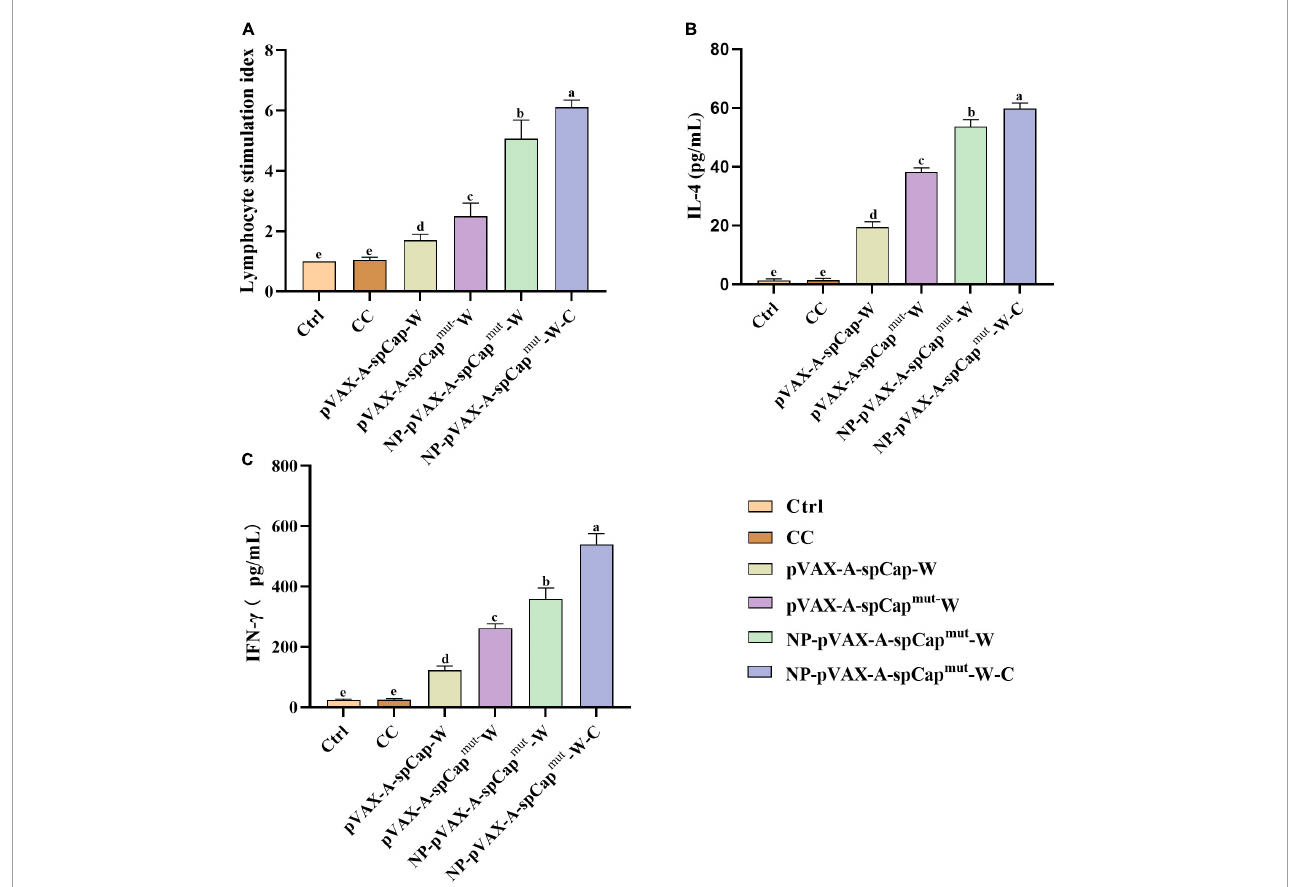
FIGURE3 The gC1qR binding site mutation Cap induces higher cellular immune response than the wild-type Cap in mice. At 28 days post-vaccination, half of the mice in each group were euthanized, and then the spleen lymphocytes were isolated for further assays. (A) The spleen lymphocytes of mice in each group were plated into 96-well plates, and stimulated by the prokaryotic expressed Cap, ConA as positive control, or medium as negative control for 68 h. Then the proliferation level of spleen lymphocytes in mice was detected by 3- (4,5)-dimethylthiahiazo (-z-y1)-3,5-di- phenytetrazoliumromide (MTT) assay. (B,C) The IL-4 (B) and IFN- γ (C) levels in the supernatant of these lymphocytes stimulated by the prokaryotic expressed Cap were detected by enzyme-linked immunosorbent assay (ELISA). The same small letters (a ∼ e) represent no significant difference among the groups, and different small letters represent significant differences among the groups in (A–C)